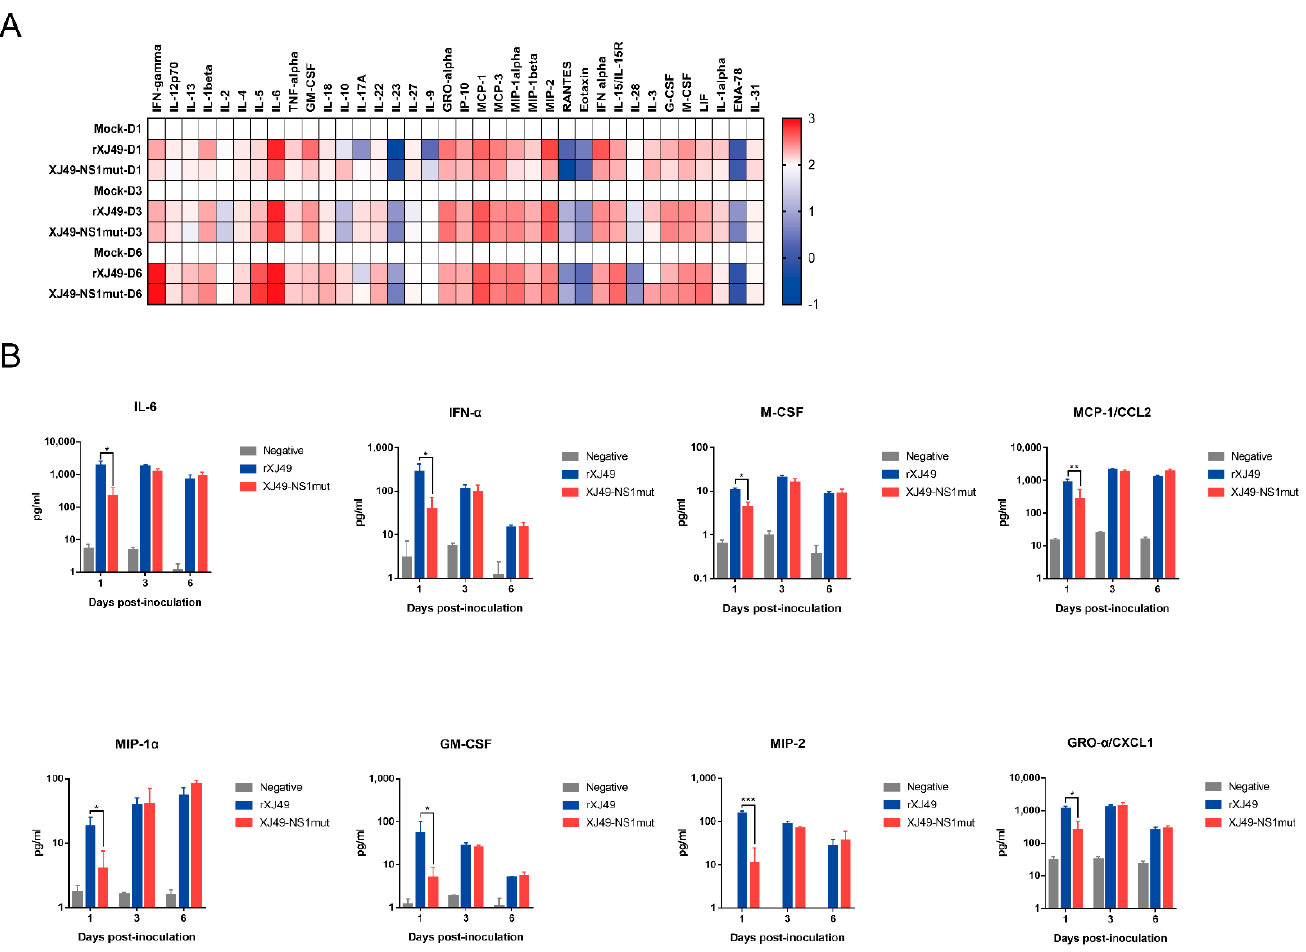
Figure 5. Differential expression of cytokines in the lung of mice infected with rXJ49 or XJ49-NS1mut. ( A ) Heat map showing differentially expression of cytokine-encoding genes in infected versus mock-infected lungs of C57BL/6N mice. Samples were analyzed using a 36-Plex mouse ProcartaPlex Panel kit. Expression of each cytokine is presented as log10-fold changes compared with the value in the mock group. ( B ) Expression of IL-6, GM-CSF, CXCL1, CCL2, MIP-1 α , MIP-2, IFN- α , and M-CSF in C57BL/6N mice infected with rXJ49, rXJ49-NS1mut, or mock. Average of biological triplicates ± SD are shown. Significance was calculated using one-way ANOVA with multiple comparison tests (*, p < 0.05; **, p < 0.005; ***, p < 0.001).